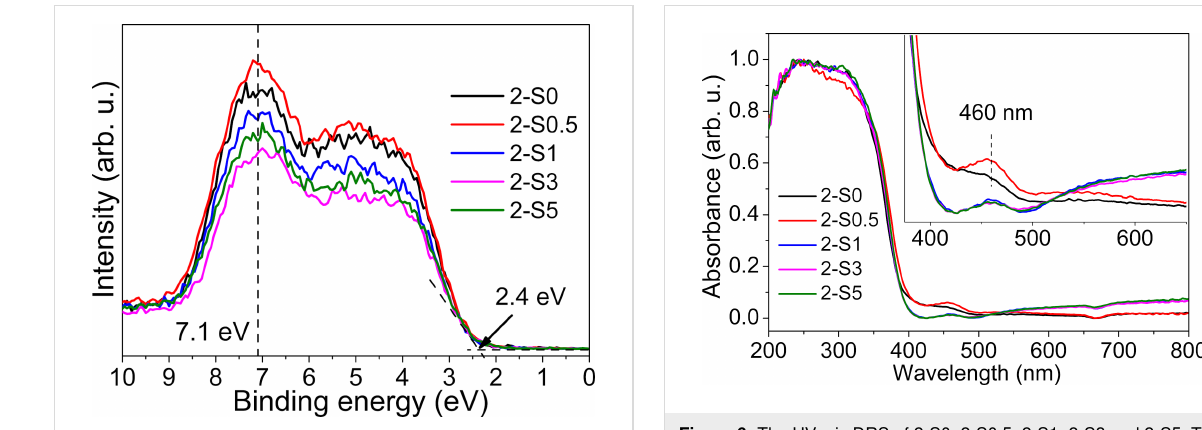
around 7.1 eV is observed in the valence band DOS curve and its intensity decreases in the order of 2-S0.5 > 2-S1 > 2-S5 > 2-S3. The states in the valence band are derived from the O 2p orbitals. At the same time, the ratio of the O v increases in the order of 2-S0.5 < 2-S1 < 2-S5 < 2-S3, as given in Table 3;